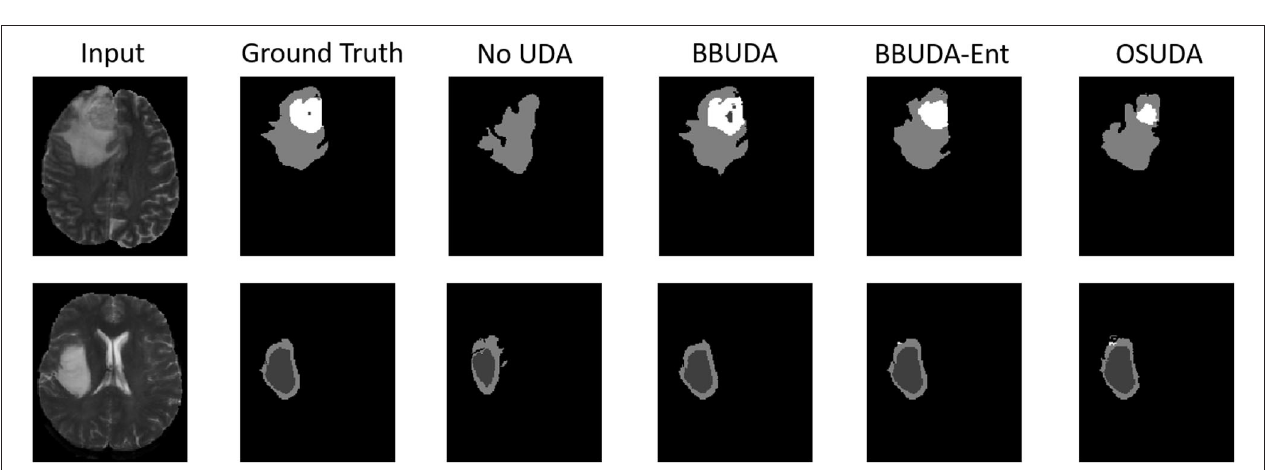
FIGURE 5 | Examples of our segmentation results from T2-weighted MRI with different methods in the T1 to T2 UDA task. In addition, BBUDA-Ent represents an ablation study of the entropy minimization. We use white, dark gray, and gray color to indicate the CoreT, EnhT, and ED, respectively. OSUDA (Liu et al., 2021k) with the white-box source model for adaptation is considered an “upper